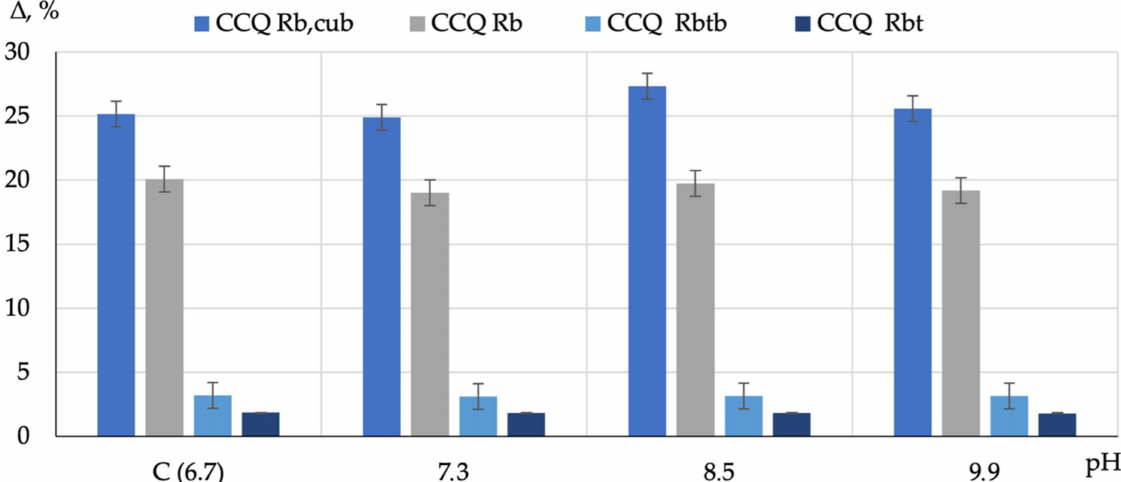
Figure 5. Dependence of the change in the structural quality coefficients of vibro-centrifuged concretes on the pH level of activated water (see Figure 3; C is the control composition; ∆ is the value of the change in the coefficients of the strength variatropic efficiency). Table 7. Integral strength and strain characteristics of prototypes of vibro-centrifuged concrete.